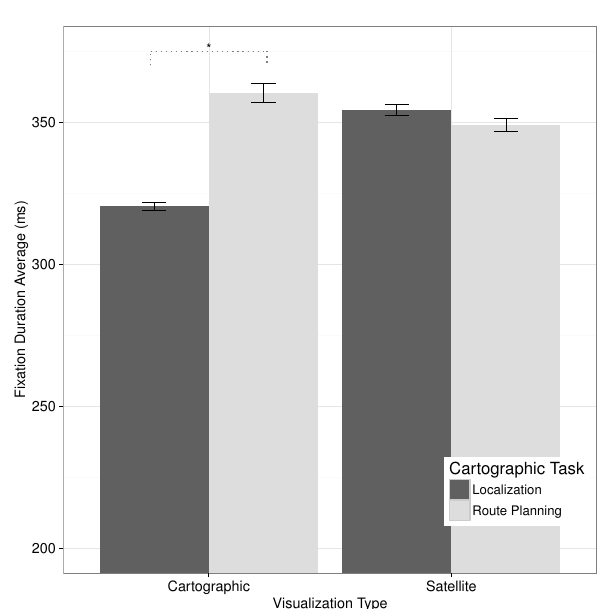
Figure 3 . Interaction e ff ect of task and visualization on av- erage fixation duration. Whiskers represent ± 1SE (standard error). Significant di ff erences ( p < 0 . 05) are marked with (cid:63)